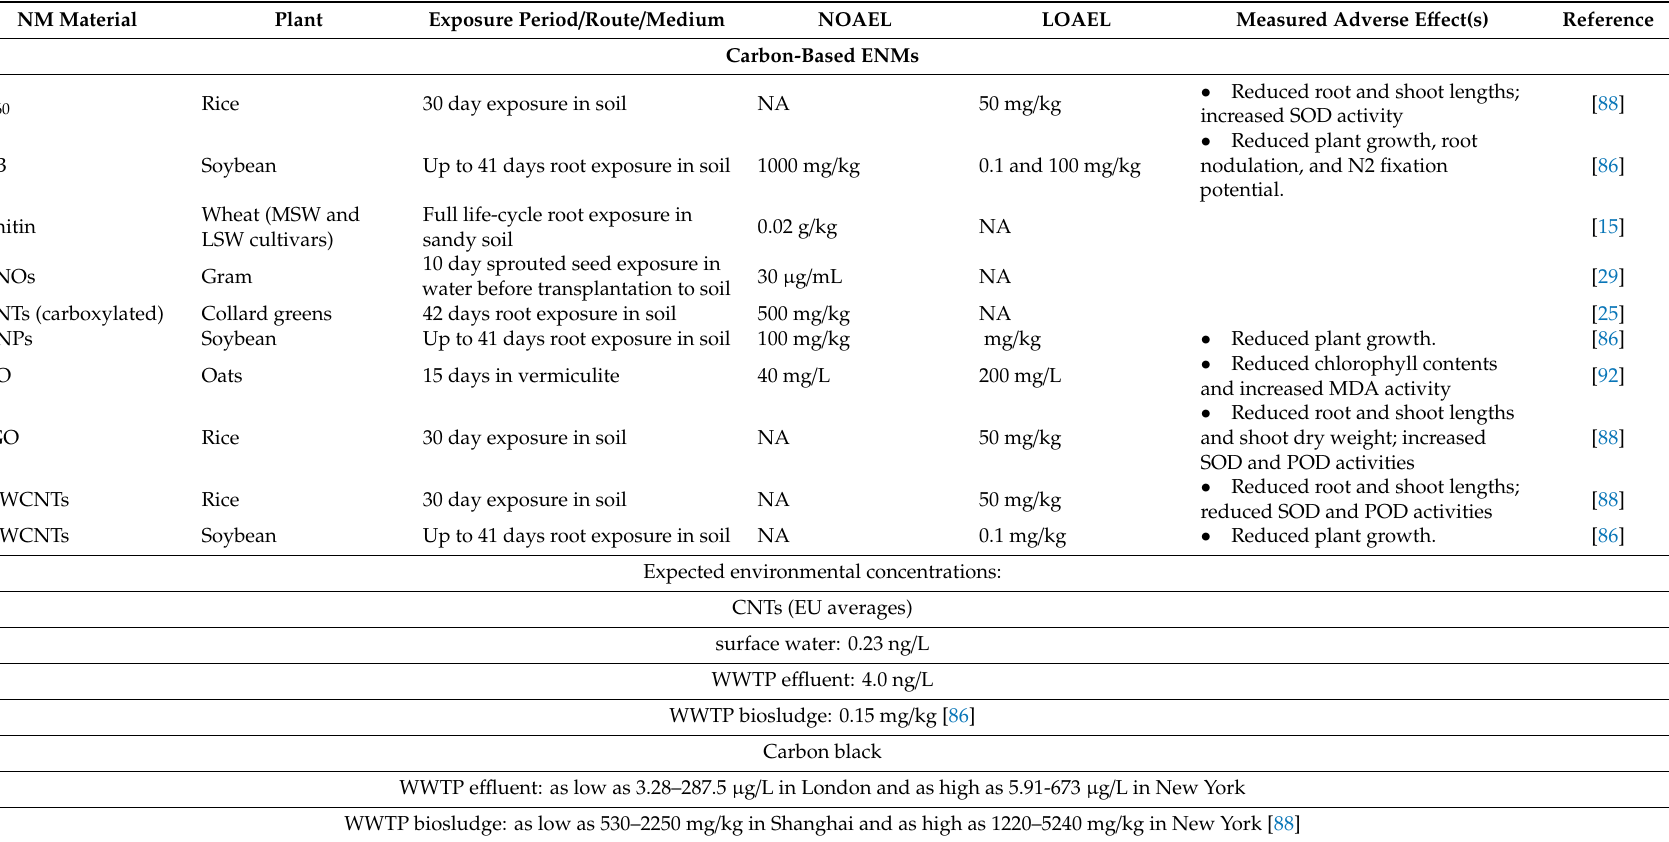
Table 5. Plant NOAEL and LOAEL values for exposure to C-, Ag-, Ce-, Cu-, Ti-, and Zn-based ENMs with the recorded adverse physiological and / or biochemical e ff